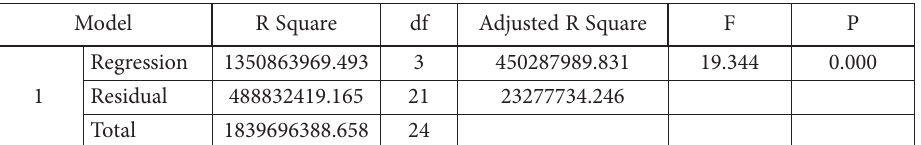
Table 6. ANOVA Regression